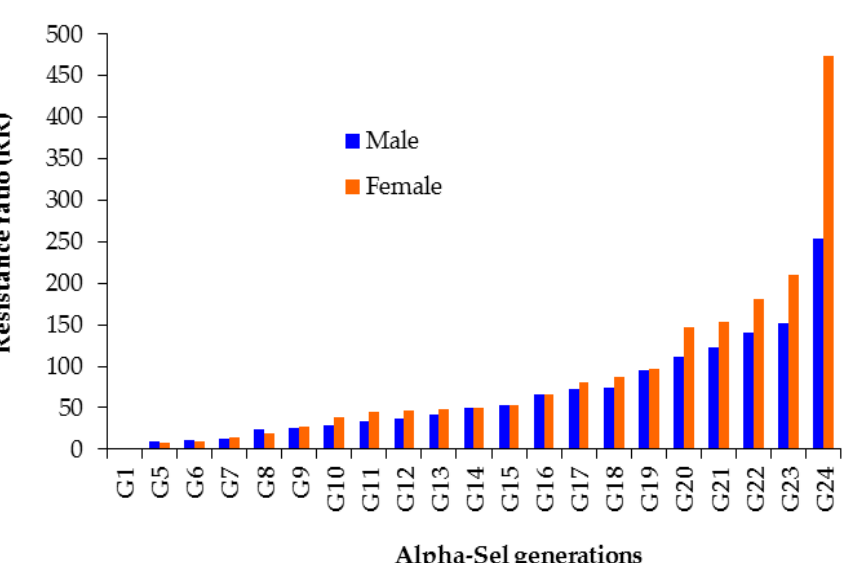
Figure 1. The trend in alpha-cypermethrin resistance development in Alpha-Sel each generation compared to respective Alpha-Unsel generation. Resistance ratio (RR) = LC 50 for alpha-cypermethrin in Alpha-Sel each generation (G 1 –G 24 )/LC 50 of alpha-cypermethrin in Alpha-Unsel respective generation (G 1 –G 24 ).